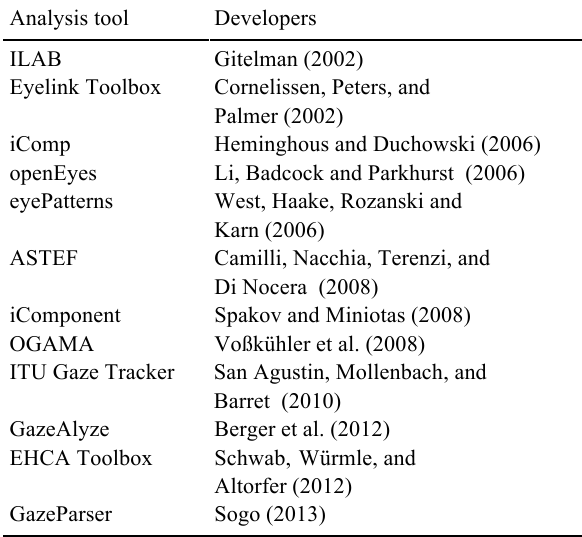
An overview of the freely available tools appropriate for the performance of eye movement